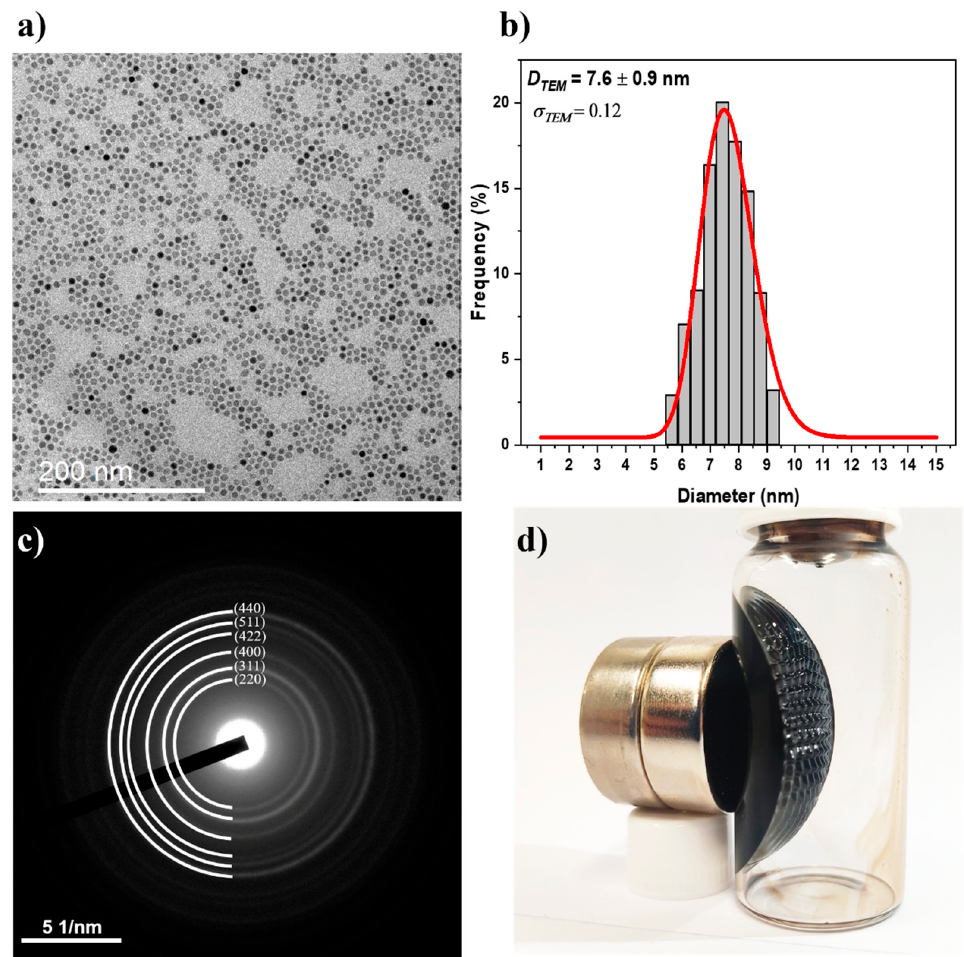
Figure 2. TEM characterization of Fe 3 O 4 nanoparticles. ( a ) TEM micrograph, ( b ) histogram of size distribution. ( c ) SAED pattern, and ( d ) behavior of nanoparticles in the presence of a magnetic